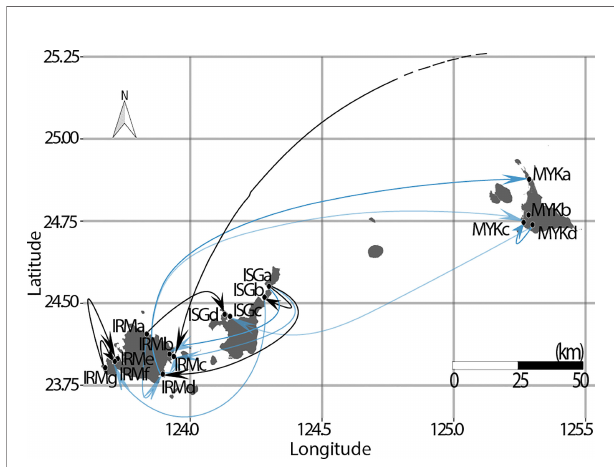
FIGURE 7 | All migration patterns with m > 0.05 were projected over a map with arrows pointing at target sites. The higher migration rates ( m > 0.1) for R. stylosa in the Ryukyu Archipelago were unidirectional (bold arrows). The majority of site pairs with m > 0.05 were found between Iriomote and Ishigaki Islands, and site ISGa was identi fi ed as the strongest source population for gene fl ows among study sites. Black arrows have higher accuracy (F ST > 0.25).